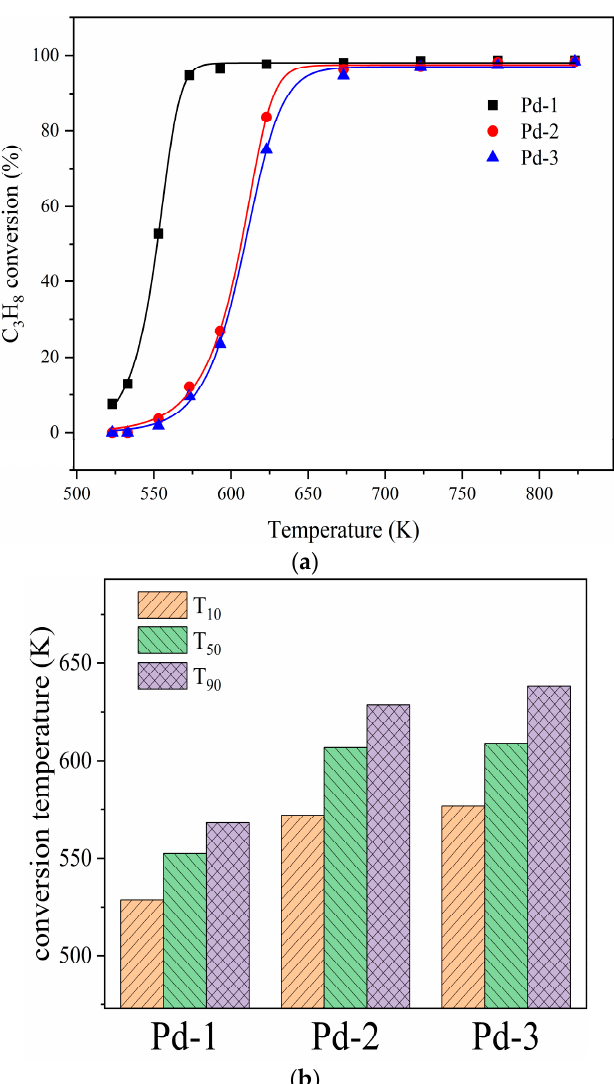
Figure 10. ( a ) Catalytic efficiency of Pd-1, Pd-2 and Pd-3 for propane. ( b ) T 10 , T 50 and T 90 Pd-1, Pd-2 and Pd-3 for propane.